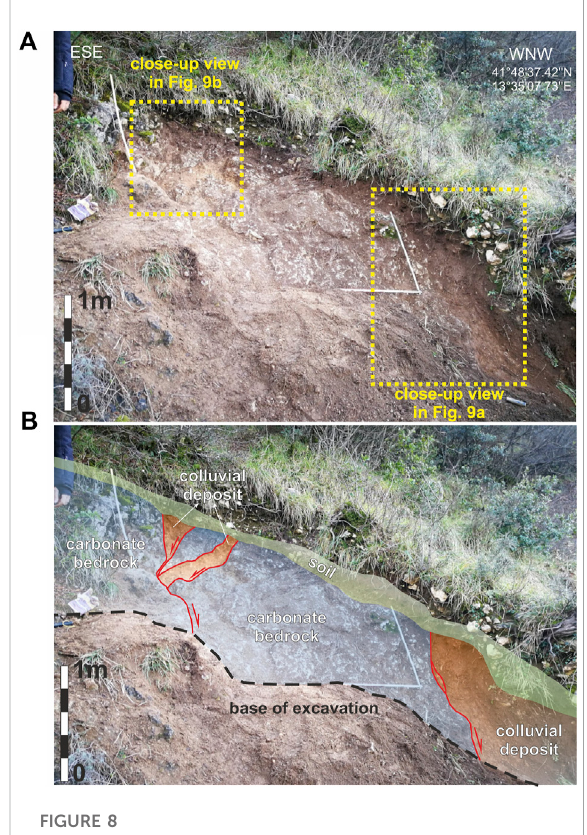
FIGURE 8 (A) View of the handmade excavation made at the “ Le Chieie ” site; the yellow boxes show details of the shear zones. (B) Stratigraphic scheme of the excavation